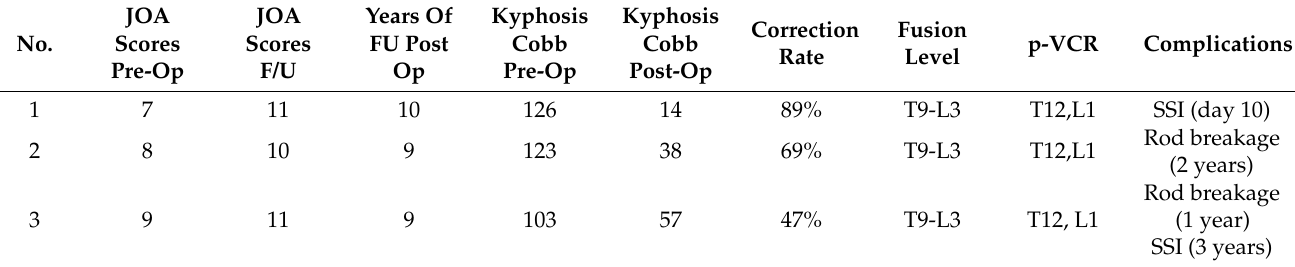
Table 1. Summary of clinical